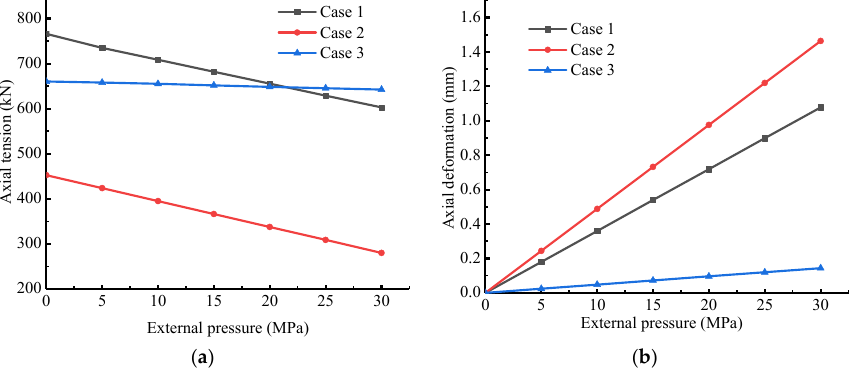
Figure 10. Influence of external pressure on axial deformation. ( a ) Axial tension versus external pressure per unit length, ( b ) axial deformation versus external pressure per unit length.